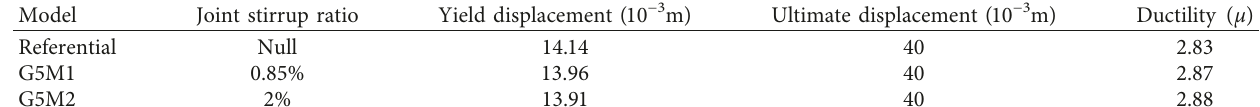
Table 20: Yield and ultimate displacement for ductility determination.